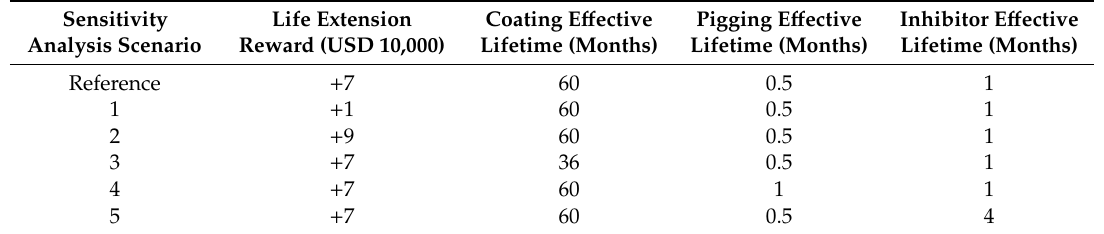
Table 7. Di ff erent scenarios of RL agent sensitivity